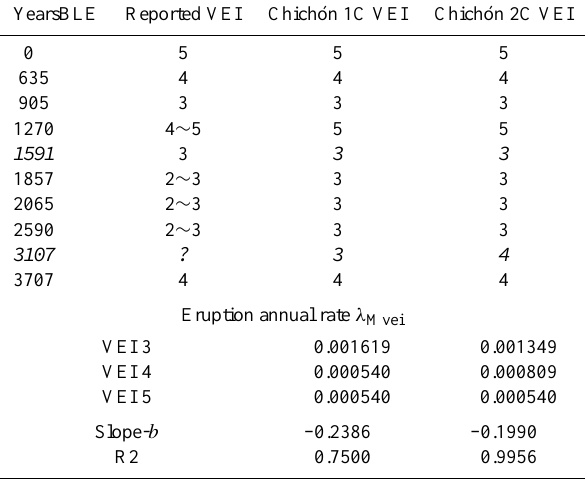
Table 9. Models and Eruption rates λ Mvei for each VEI class, the slope - b of the loglinear relationships from Eq. (1), and the regression coefficients for the two models for El Chich´on vol- cano in the period 3707years BLE assuming the eruptive sequence